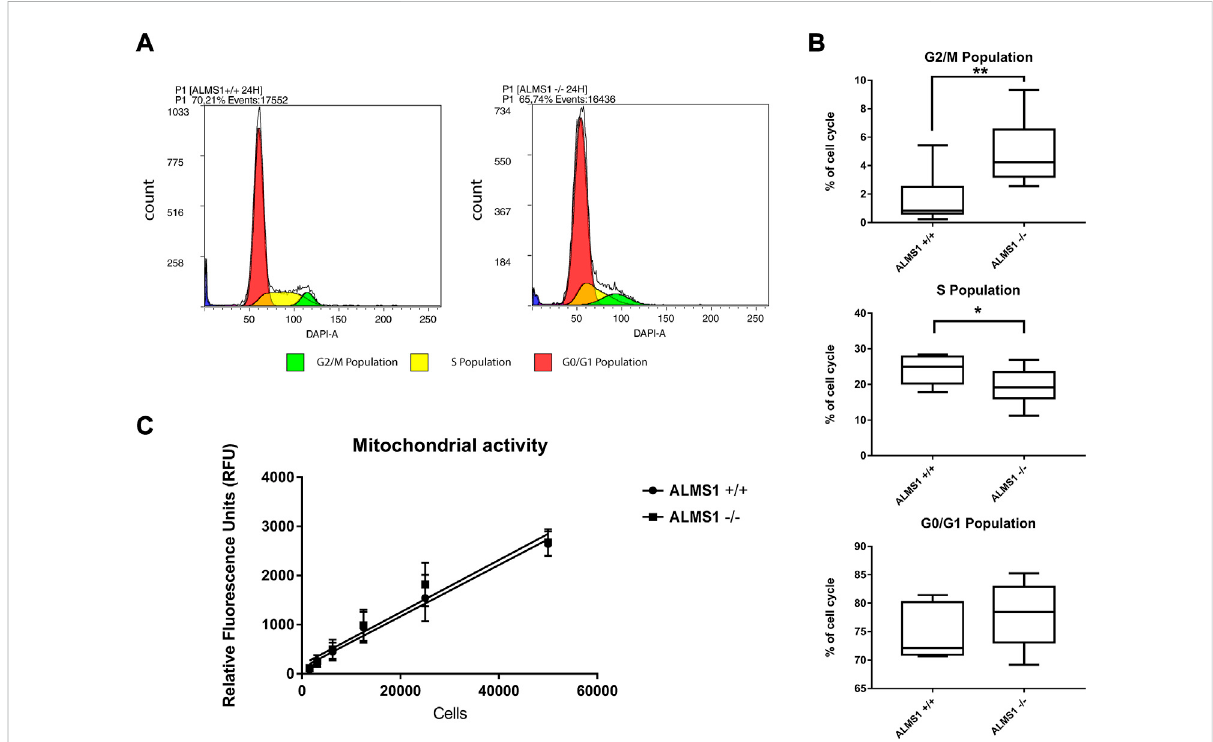
FIGURE 1 Cellcycleassayandmitochondrialactivityresults. (A) CytometryplotswithDAPI fl uorescenceandeventscount.Colourscorrespondwitheach population de fi ned by fox synchronous algorithm. (B) Box-plot for each population previously de fi ned in the cytometry plot that represents the percentage of cell cycle populations from parent population. (C) Linear regression between relative fl uorescence units (RFU) and cell concentration inbothgenotypes( ALMS1+/+ and ALMS1 − / − ).Thisexperimentwascarriedoutintriplicateandrepeated3timesondifferentdays(N=3, n =3). *: p -value < 0.05, **: p -value <